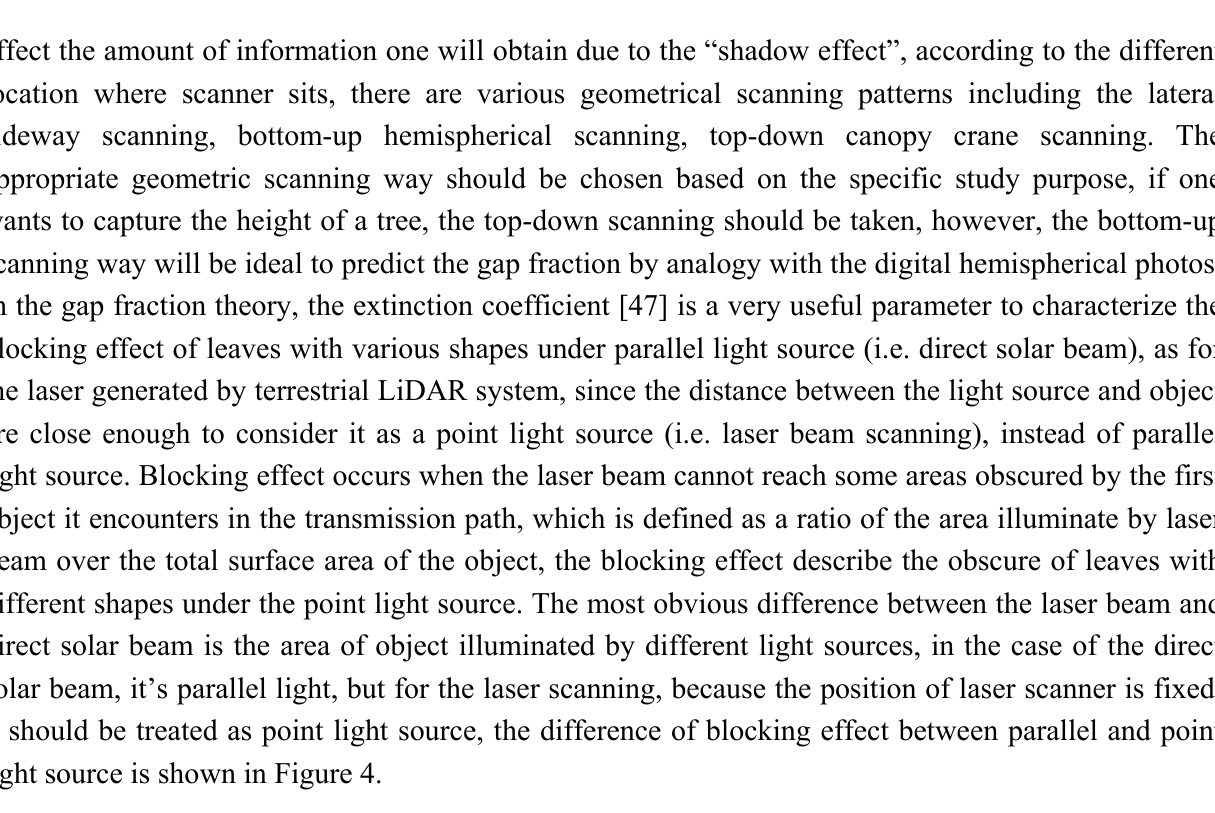
Figure 4. “Blocking effect” between direct solar beam and point light source laser